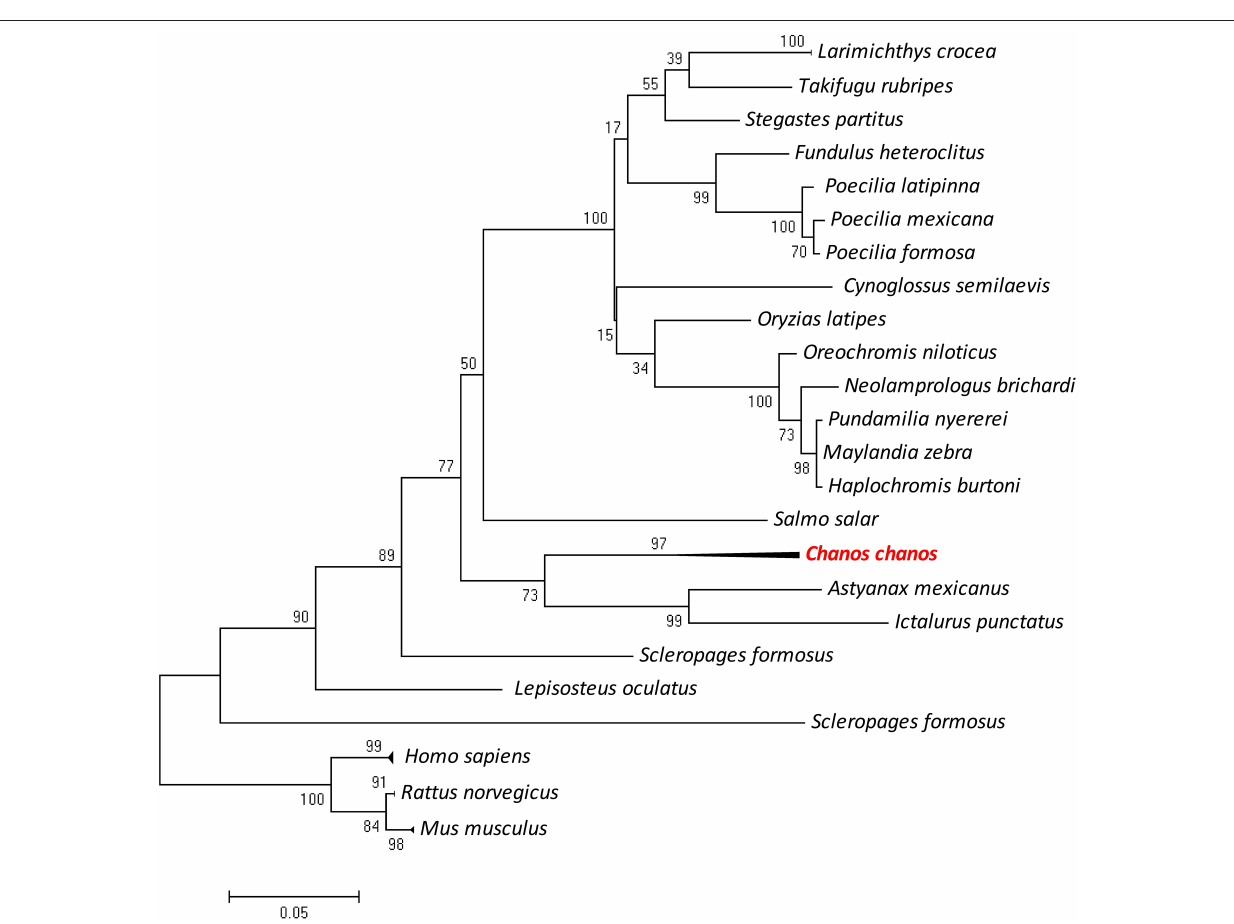
Different Patterns of Hepatic